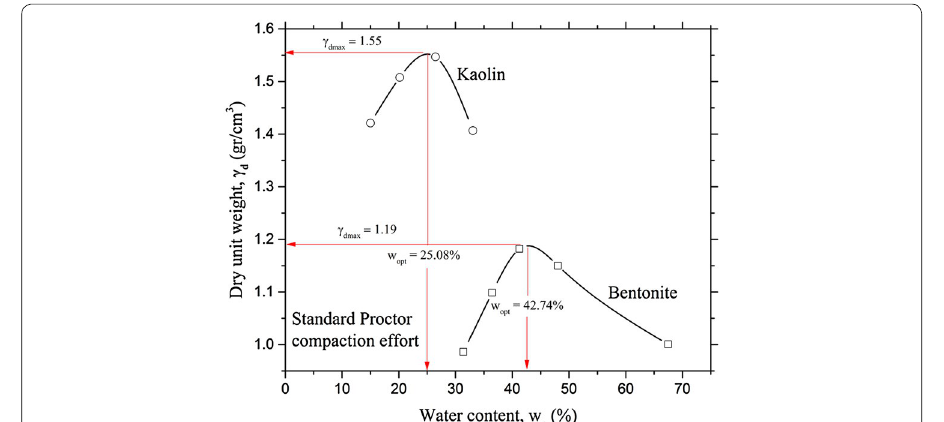
Fig. 2 Standard Proctor compaction curves of the kaolin and bentonite used in this study